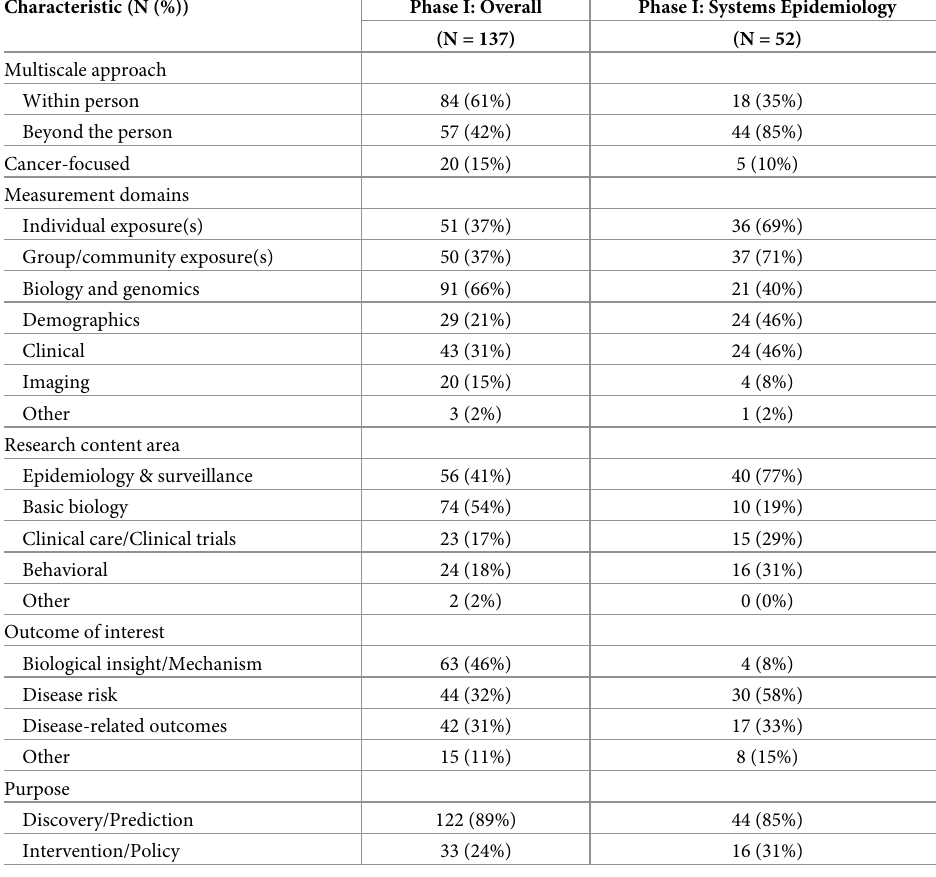
Table 3. Characteristics of phase I grants: Overall and systems epidemiology specific aims a . Characteristic (N